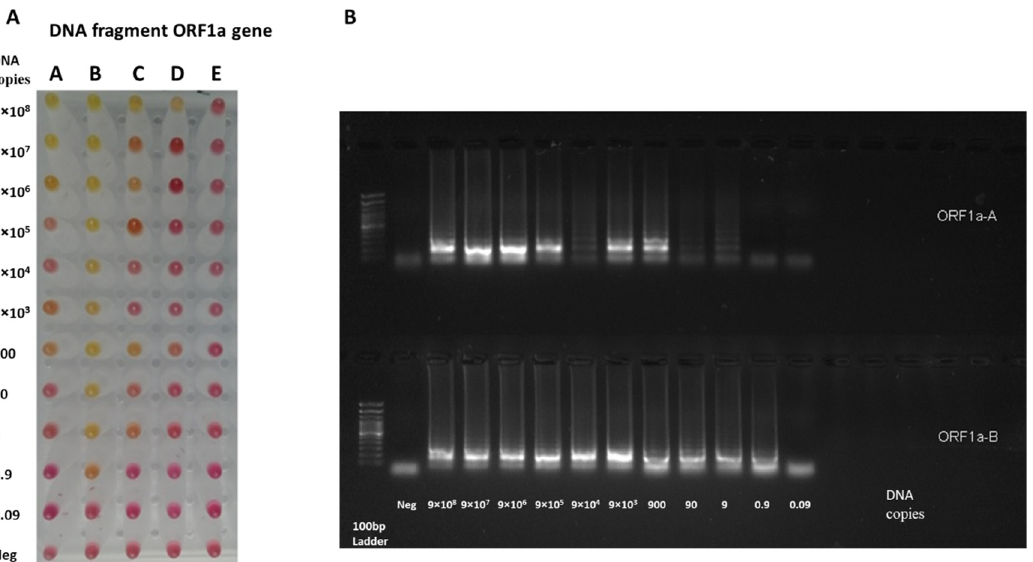
Figure 3. RT-LAMP sensitivity assay on ORF1a target using DNA samples. ( A ) The RT-LAMP assay was performed on DNA synthesized fragments. The assay was performed on five primer targets on the ORF1a gene (A, B, C, D, and E). The reaction was performed with a serial dilution of the ORF1a fragment, starting from 9 × 10 8 to 0.09 copies. The reaction was incubated in the heat block at 65 °C for 30 min. ( B ) The gel electrophoresis for A and B targets the ORF1a gene. The B primer set has demonstrated a high level of sensitivity to detect one copy of the DNA fragment of the ORF1a gene.